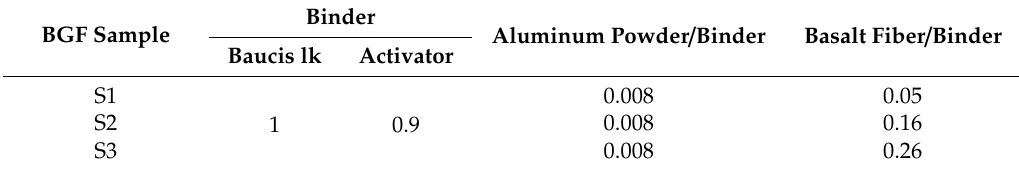
Table 2. Mix proportions of basalt fiber-reinforced geopolymer foam (BGF) samples by weight ratio.